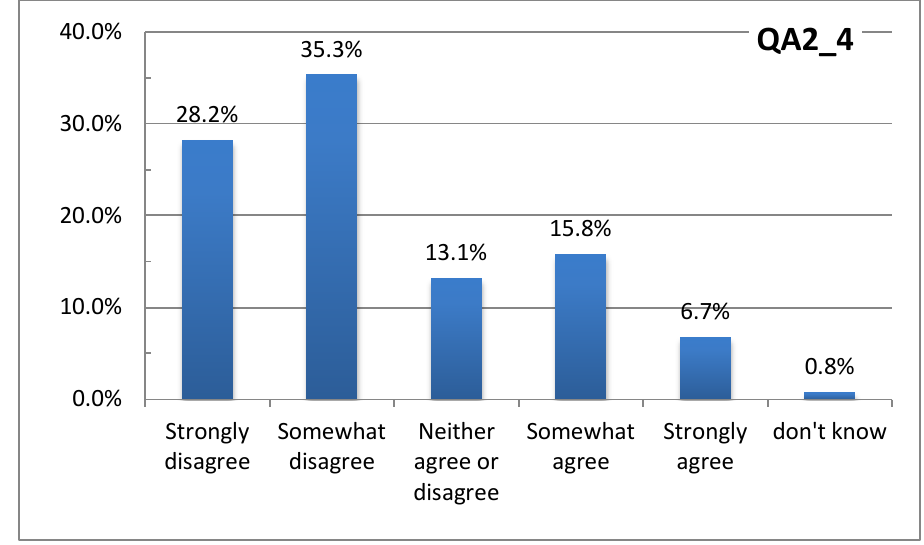
Figure 2. Respondent agreement or disagreement with the statement: “Only people in very poor health are at risk of illness or even death during heat waves”.